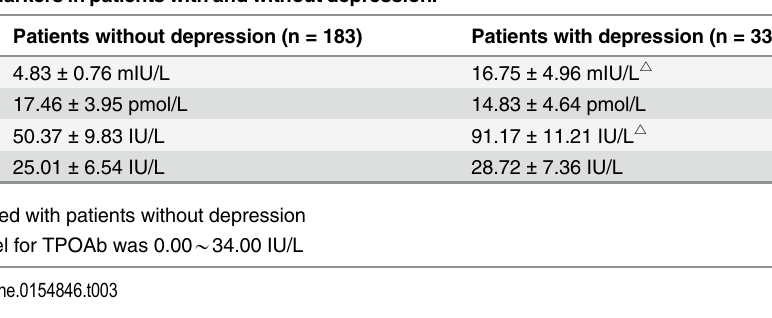
Table 3. Serum markers in patients with and without